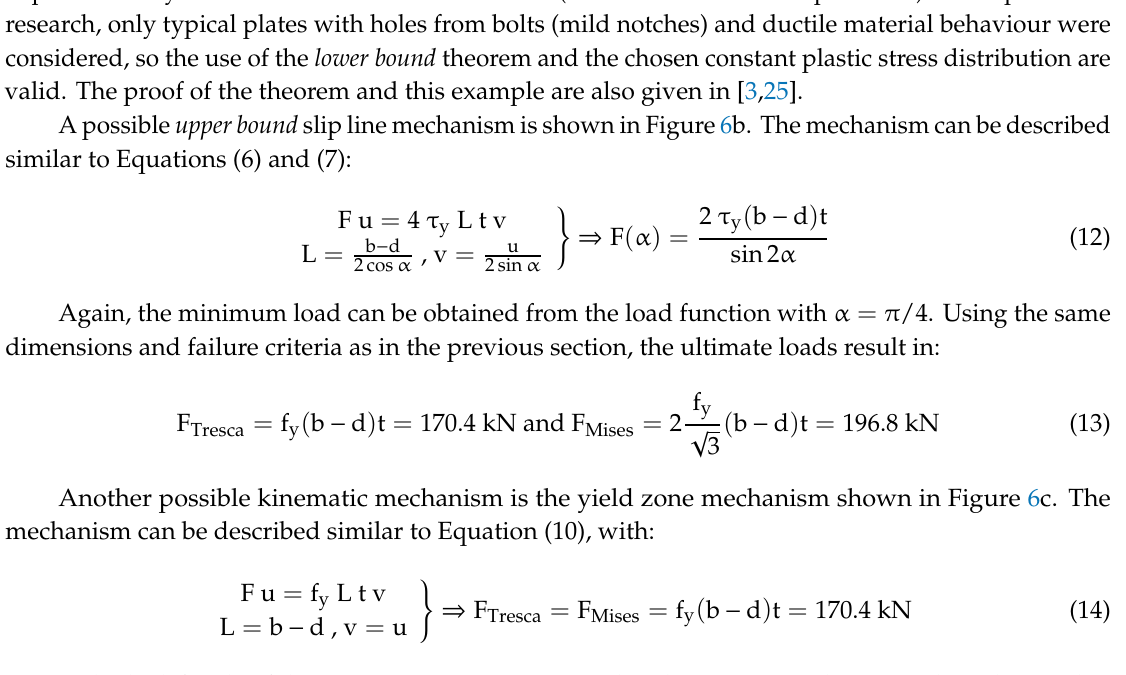
Figure 6. Tensile specimen with a hole: ( a ) Loading and boundary conditions; ( b ) slip line mechanism; ( c ) yield zone mechanism.